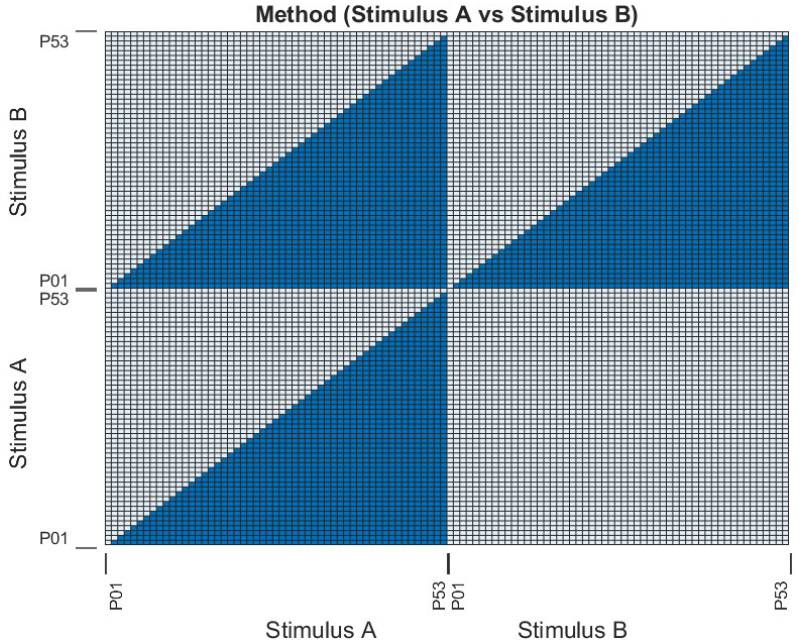
Figure 8. Illustration showing portions of the heatmap (solid colour) used in statistical testing. These triangular wedges omit repeating members (white) of the heatmap; e.g., match scores for (P05, P23) duplicate the match scores for (P23, P05), (P10, P10) are redundant, and all matches in Stimulus B versus Stimulus A match all those in Stimulus A versus Stimulus